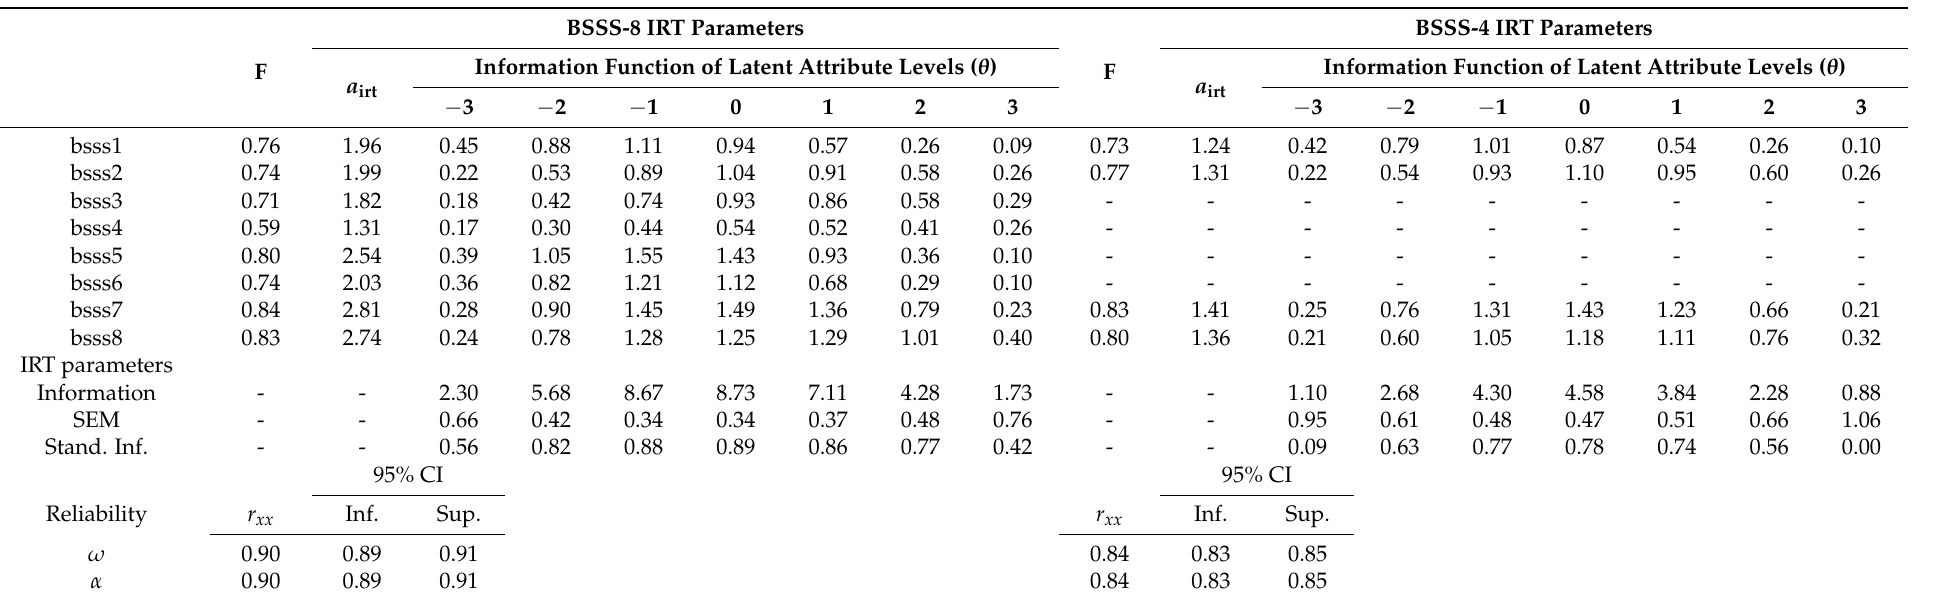
Table 3. Results of the factor analysis and item response theory (IRT)